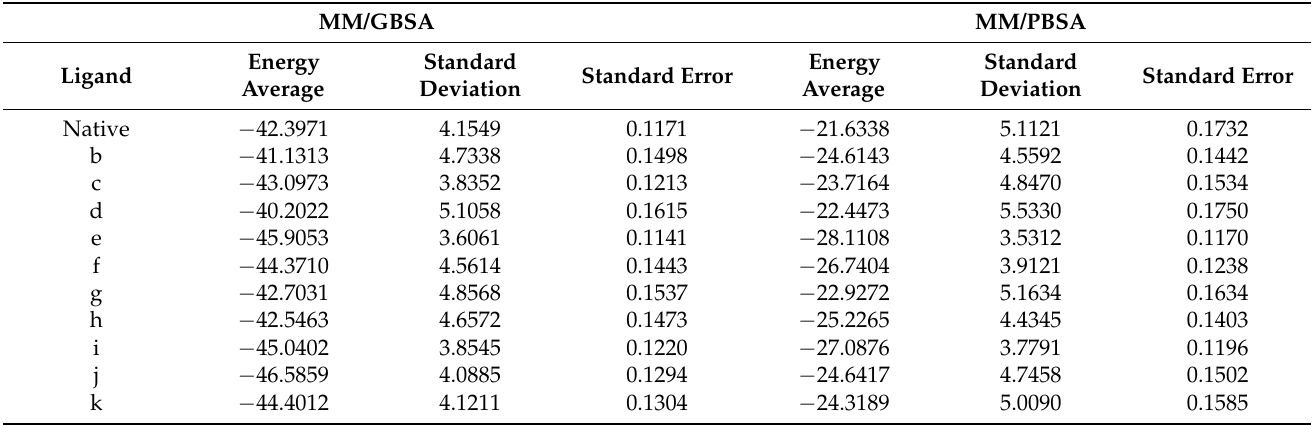
Table 6. Free binding energy to the 4X5P protein calculated using MM/GBSA and MM/PBSA